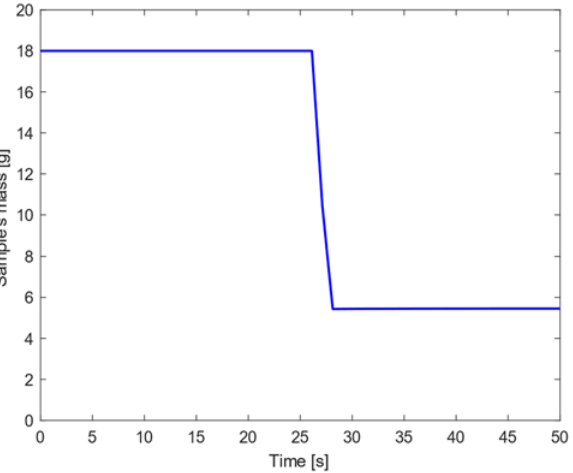
Figure 13. Sample’s mass decrease for stainless steel AISI316L when high heat flux is considered.